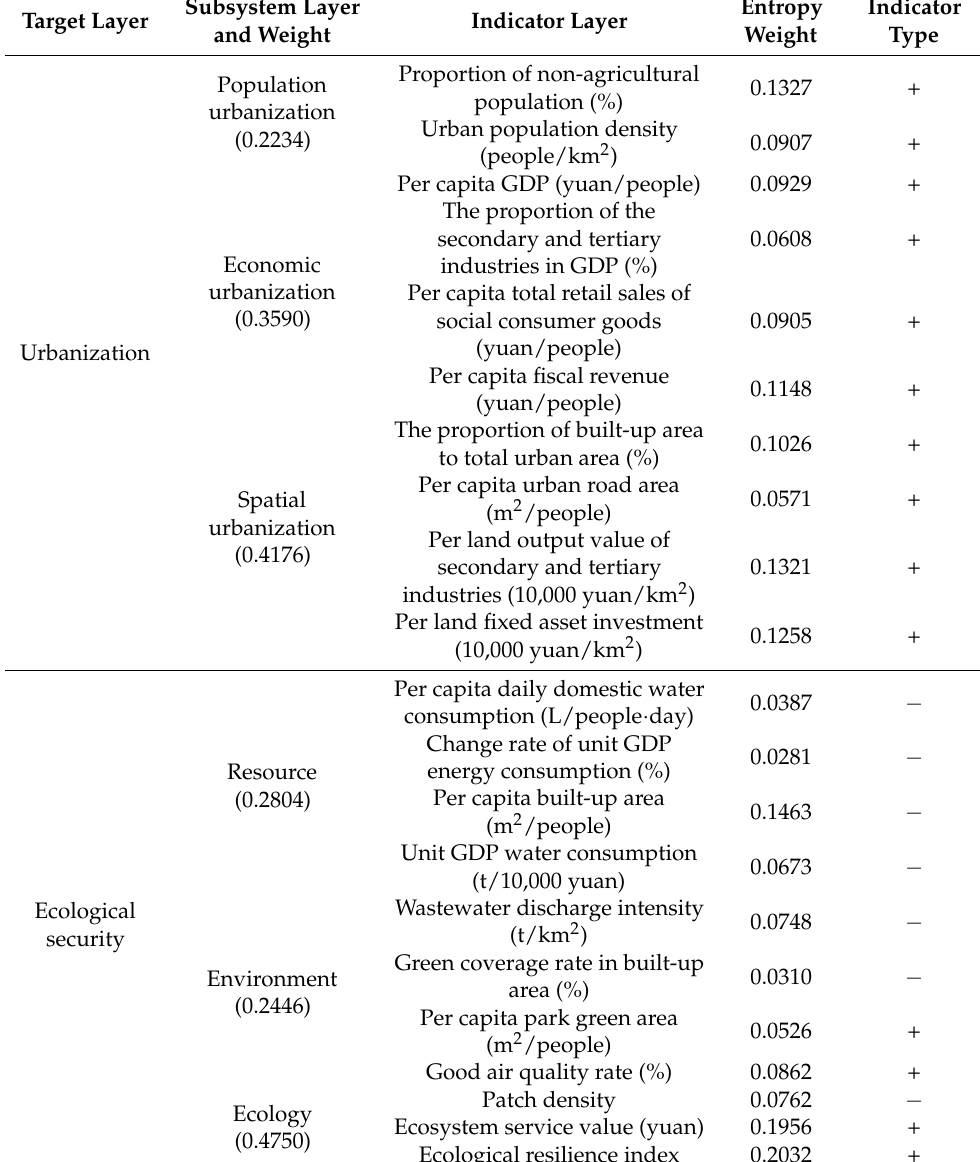
Table 1. The urbanization and ecological security evaluation indicators